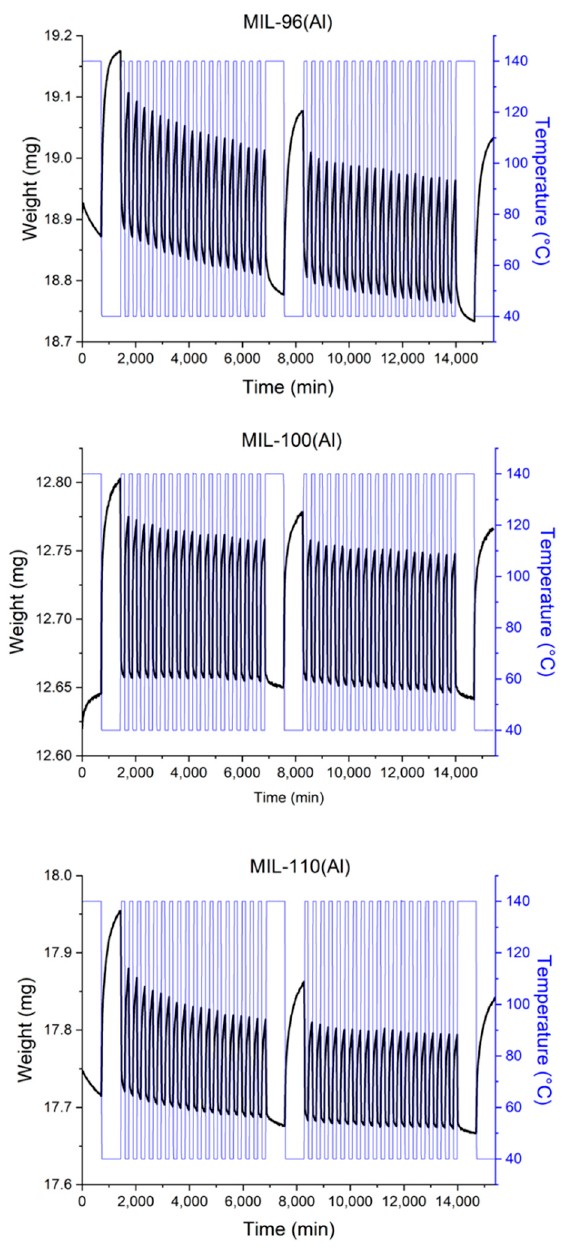
Figure 5. Hydrothermal cycling treatment of water adsorption/desorption for MIL-96(Al), MIL- 100(Al) and MIL-110(Al) materials between temperatures of 40 °C and 140 °C at 75% relative humidity under a helium gas flow.